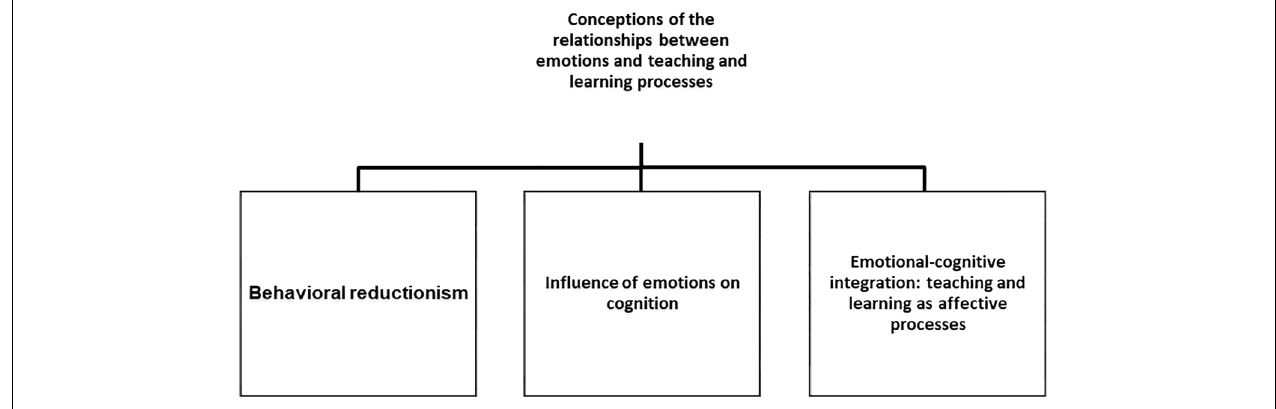
FIGURE 1 | Conceptions about the relationships between emotions and teaching and learning